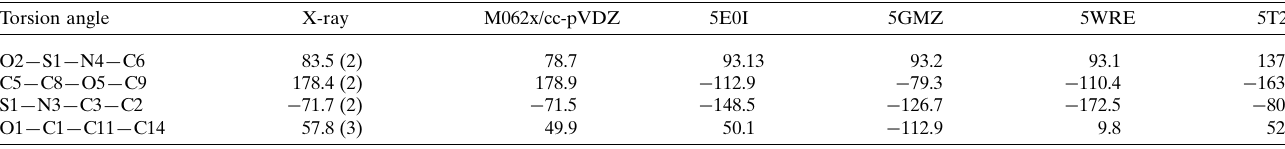
Table 4 Torsion angles ( (cid:2) ) comparison for X-ray, ab initio and docking data. Torsion angle